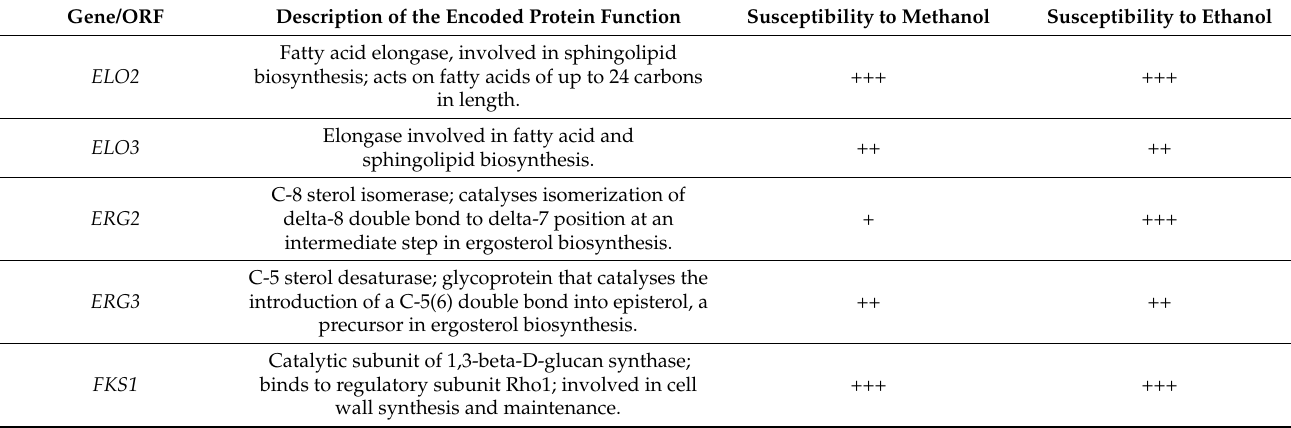
Table 3. Genes involved in reserve carbohydrate, cell wall, and membrane biosynthesis identified in this study as determi- nants of yeast tolerance to methanol, compared with ethanol. Symbols are as in Table 1. Gene/ORF Description of the Encoded Protein Function Susceptibility to Methanol Susceptibility to